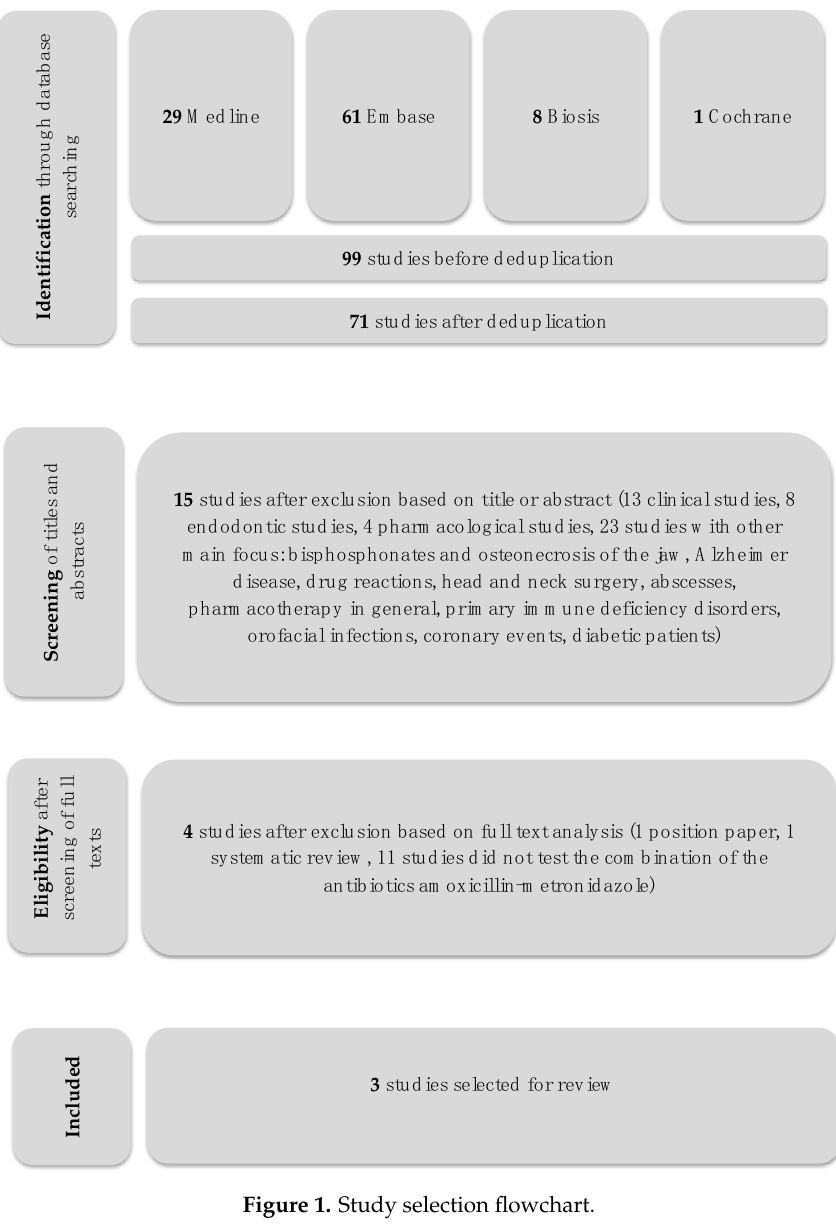
Figure 1. Study selection flowchart.